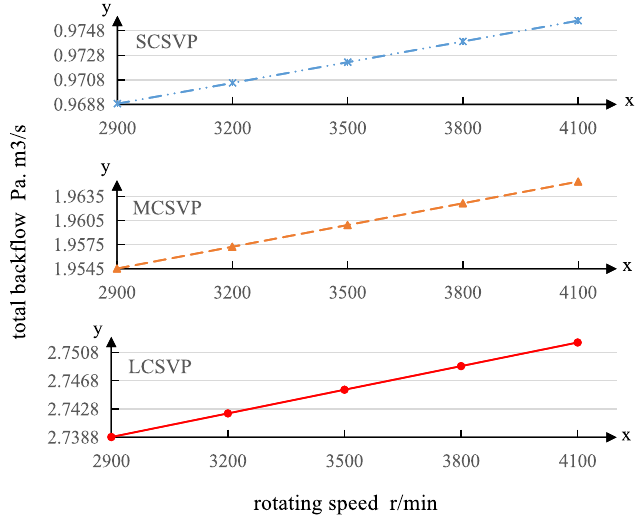
Fig. 21. Effects of rotating speed on total back fl ow.